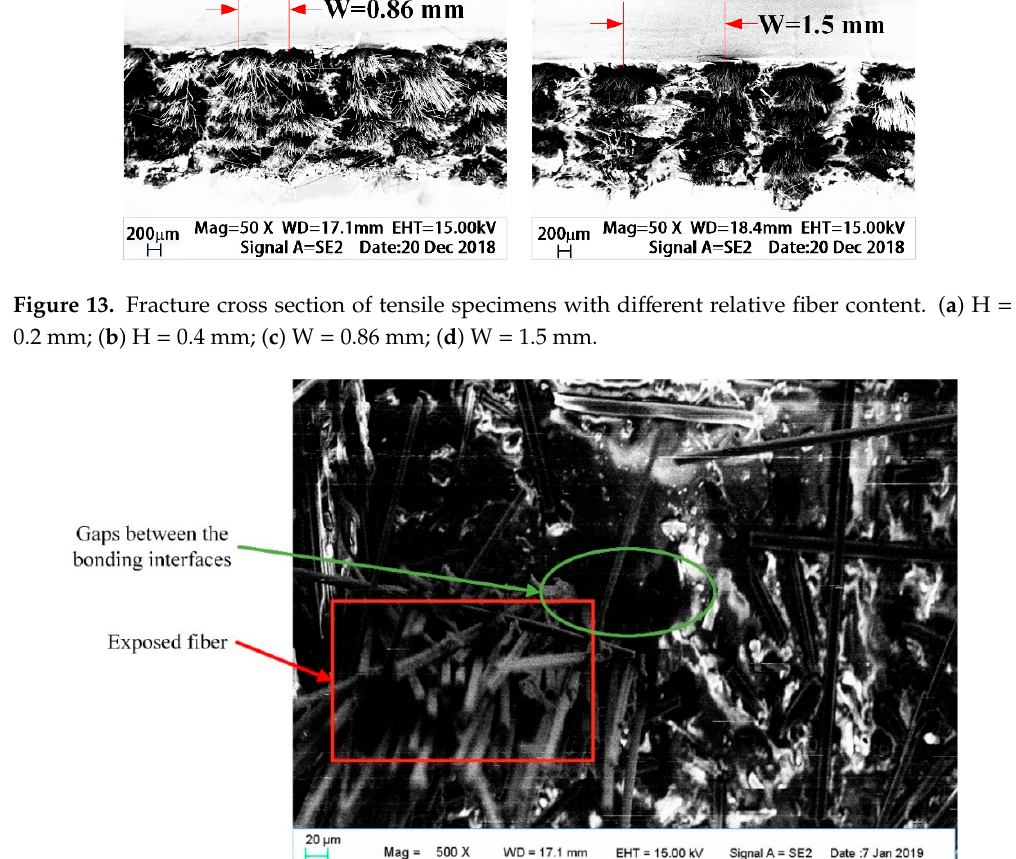
Figure 13. Fracture cross section of tensile specimens with different relative fiber content. ( a )H=0.2mm; ( b ) H=0.4mm; ( c ) W=0.86mm; ( d ) W=1.5mm.